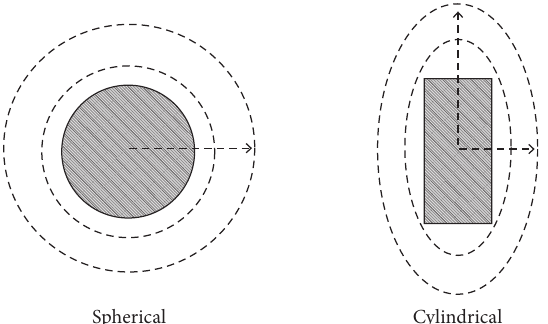
Figure 2: Explosive wave characteristics produced by two charge